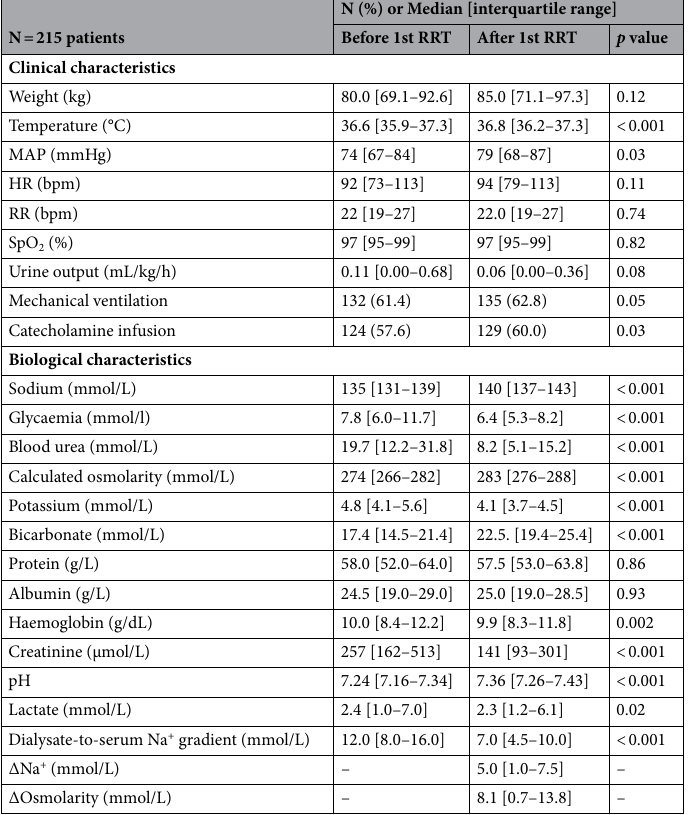
Table 2. Characteristics before and after the first renal replacement therapy (RRT) session. RRT renal replacement therapy, MAP mean arterial pressure, HR heart rate, RR respiratory rate, ∆: change during RRT (value after RRT − value before